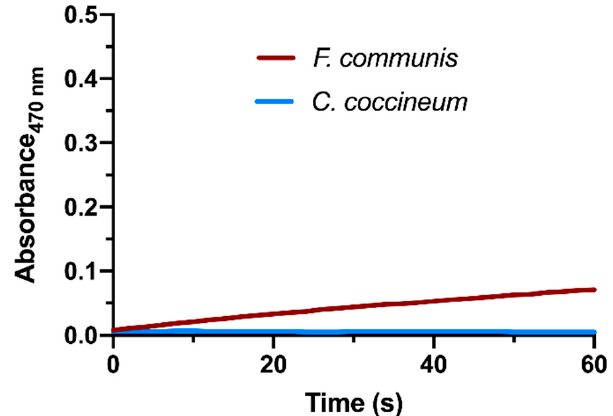
Figure 1. Dopamine oxidation assay of polyphenyl oxidase (PPO): Cynomorium coccineum homogenate (blue line) vs. giant fennel ( Ferula communis ) whole plant homogenate used as a positive control.